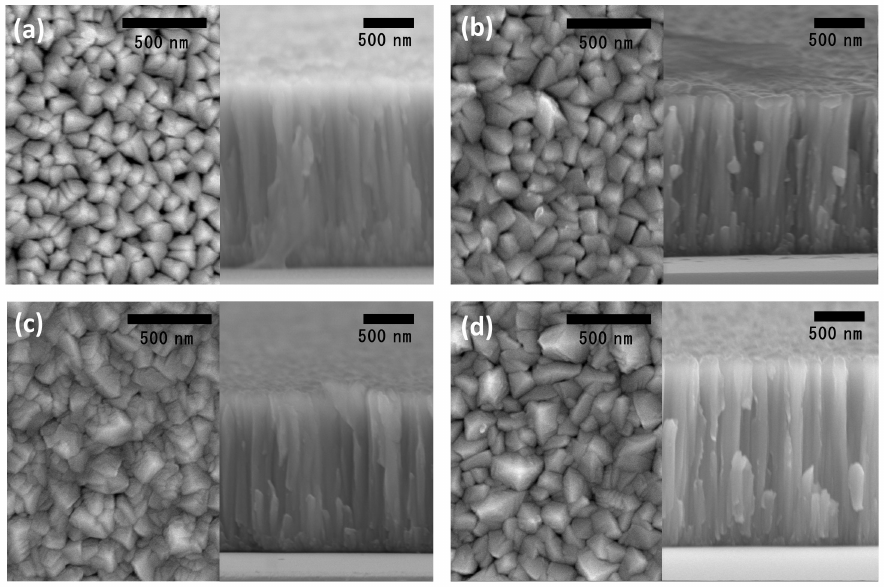
Figure 3. Surface and cross-section images of Nb-coated 316L at the various voltages: ( a ) 200 V, ( b ) 400 V, ( c ) 600 V, and ( d ) 800 V.